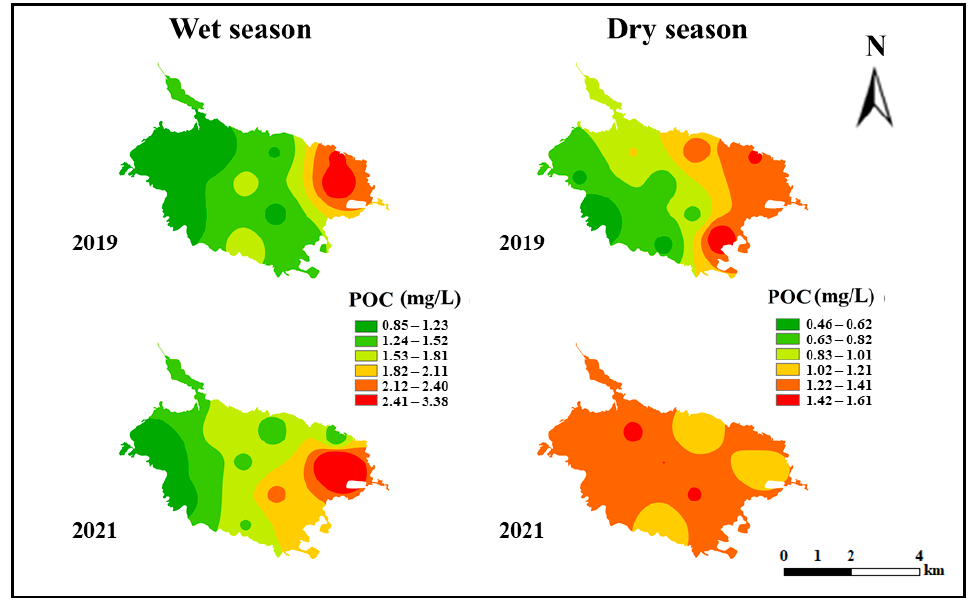
Figure 3. The temporal and spatial distribution of the concentrations of POC in wet season and dry season of Caohai Lake.